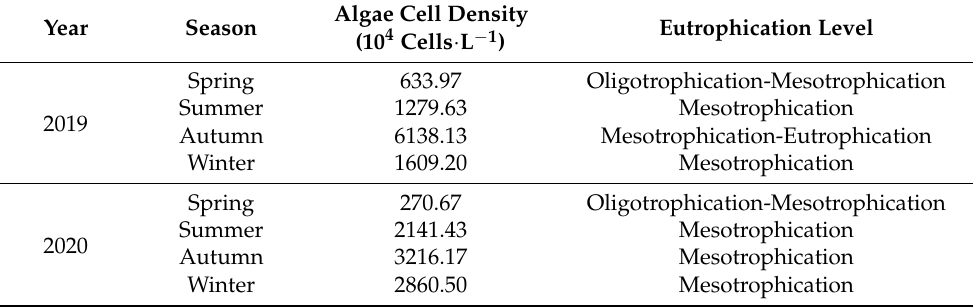
Table 3. Algae cell density and eutrophication status of Bao’an Lake.